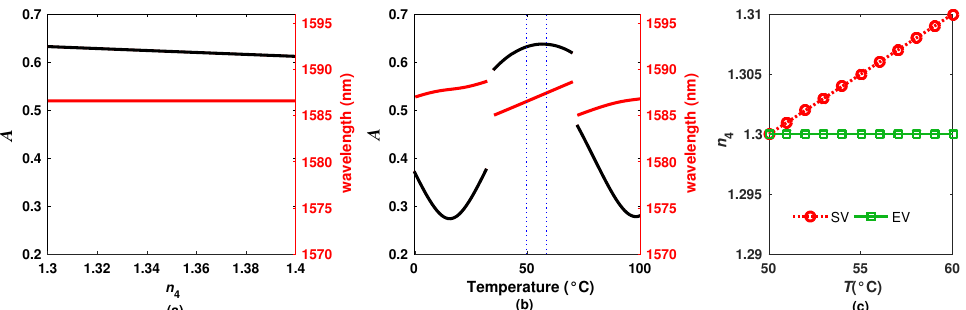
Figure 5. Simulated peak amplitude of the fringes ( a ) P1 and ( b ) P3 as a function of n 4 and T ; ( c ) Reference set of refractive index and temperature values (SV) considered in the simulations compared with the estimated values (EV) obtained with the dual-parameter sensing